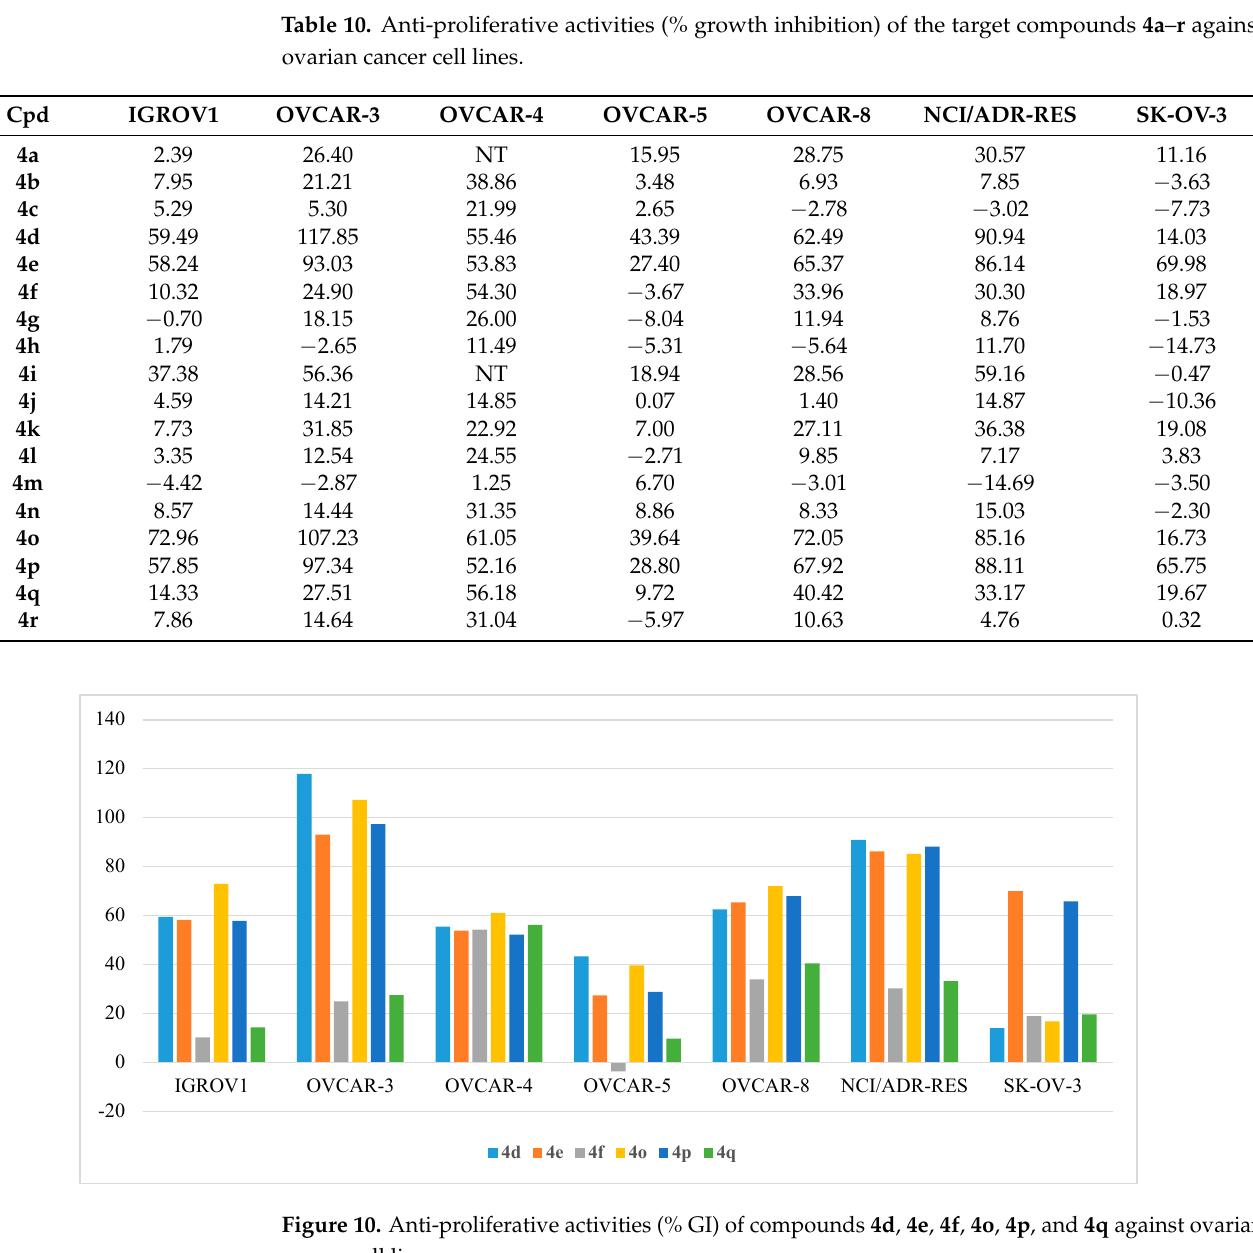
activity was detected against three cell lines: SK-OV-3 by compounds 4e and 4p (69.98% and 65.75%, respectively); OVCAR-8 by compounds 4d , 4e , 4o , and 4p (62.49%, 65.37%, 72.05%, and 67.92%, respectively); OVCAR-4 by compounds 4d , 4e , 4f , 4o , 4p, and 4q (55.46%, 53.83%, 54.30%, 61.05%, 52.16%, 56.18%, respectively); and IGROV1 by compounds 4d , 4e ,